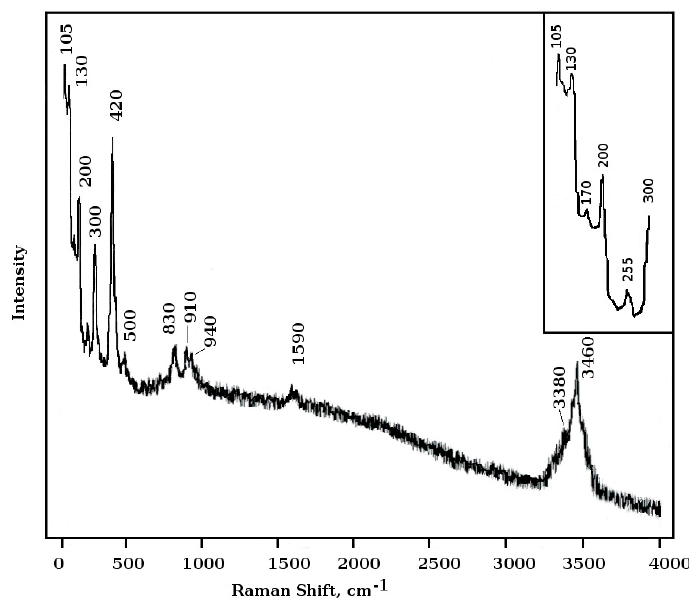
Figure 3. The Raman spectrum of dioskouriite and its enlarged low-frequency fragment.